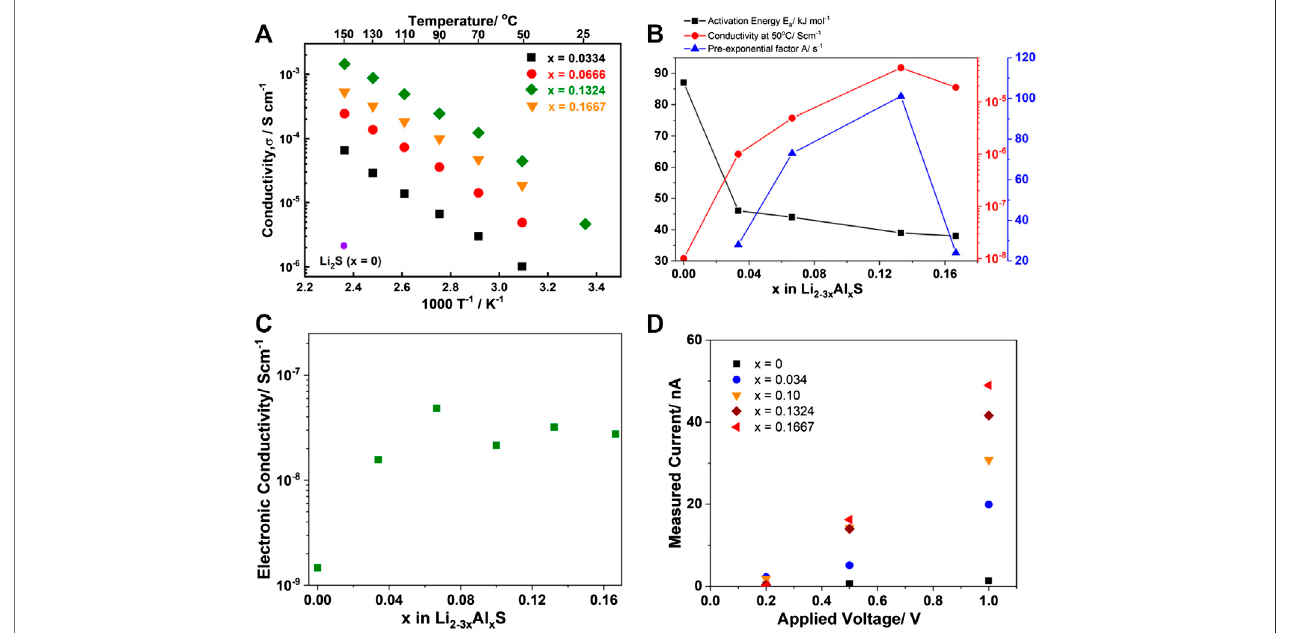
FIGURE 2 | Conduction properties of the Li ≤ x ≤ 0.1667) samples. (A) Temperature dependence of ionic conductivity; (B) Activation energy (closed 2-3x Al x S (0 square), ionic conductivity at 50 ° C (closed circle), and pre-exponential factor A (closed triangle) as a function of x . Conductivity and activation energy of sample x = 0 in A,B were adapted from references (Hakari et al., 2017; Lorger et al., 2018); (C) Electronic conductivity as a function of x ; and (D) I – V correlation of the Li 0.1667) samples.